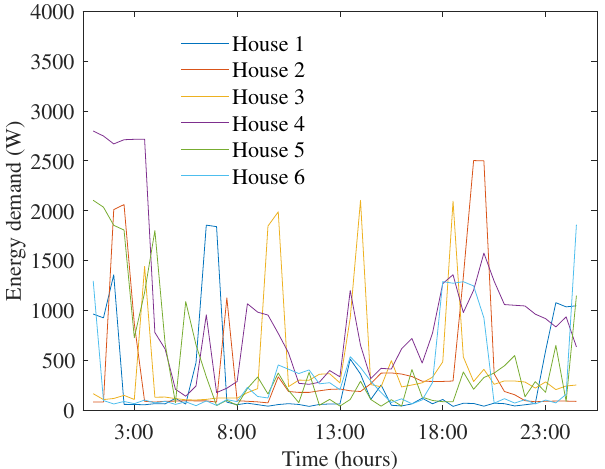
Figure 3. Demand profile of the 6 houses under microgrid